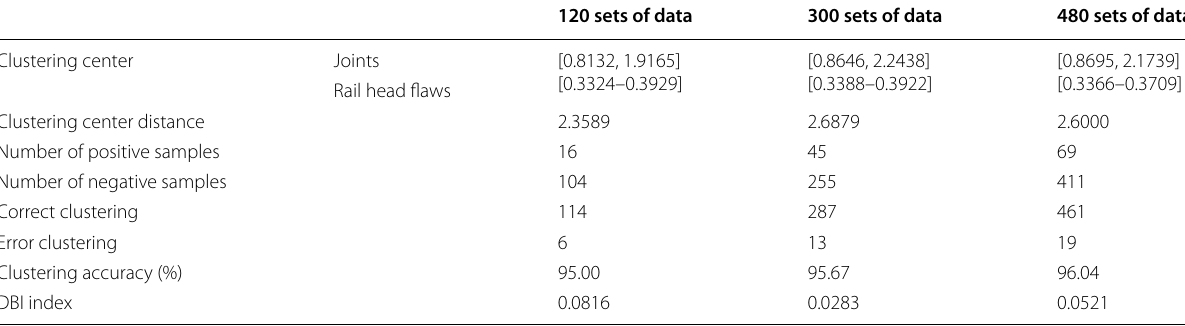
Table 5 Clustering results of rail head region